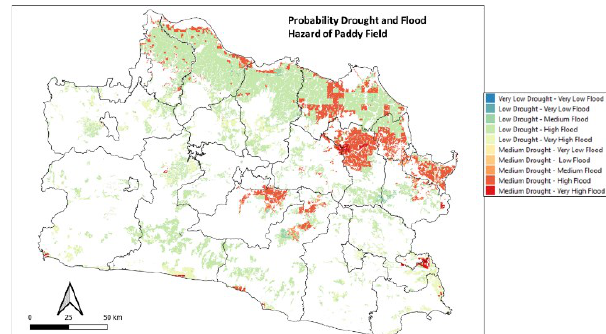
Figure 8 . Probability model of hazards in the rice fields in 2021 The danger of floods and droughts in rice fields in every city and regency in West Java can be calculated in Figure 9. This percentage can be used to determine the number of rice fields in a city/regency to plan policies to overcome it. It can be seen in Figure 9 that the rice fields in each city and district are dominated by high flood hazards, which reach an average of 74.88% per district/ city. While drought is dominated by low drought danger where the average of each district/city is 76.45%.